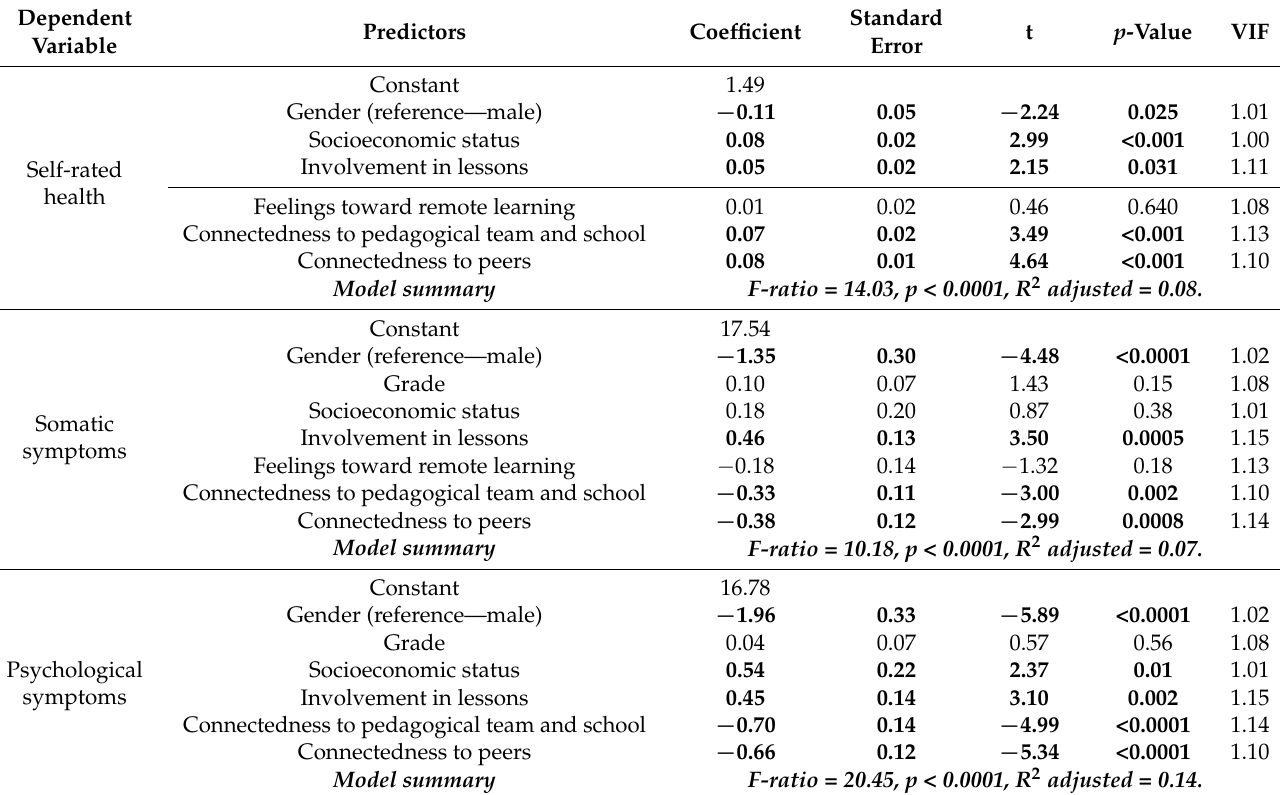
Table 6. Summary of multiple logistic regression analysis for predicting